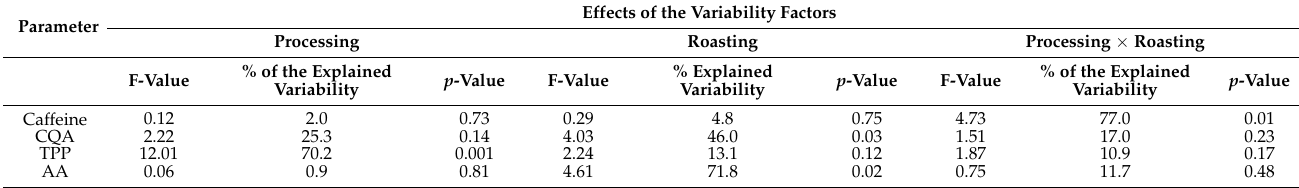
Table 2. Effect of the processing method and the degree of roasting, respectively, on caffeine, chloro- genic acid (CQA), total polyphenols (TPP), and acrylamide (AA) content in the coffee samples processed by either wet or dry method and consequently roasted to the three different degrees; two-factor ANOVA with interaction; n =